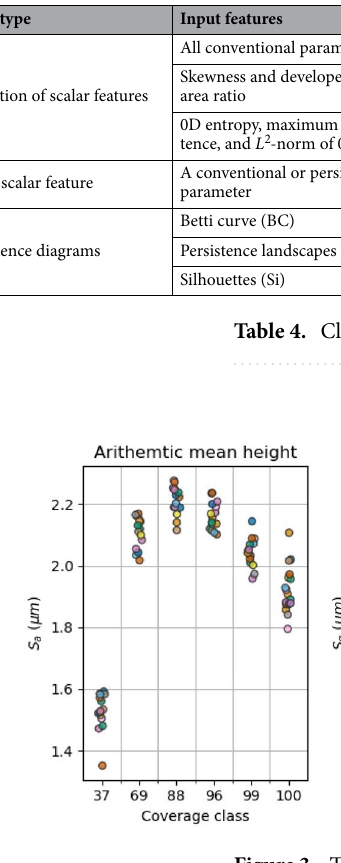
Figure 3. The conventional surface roughness parameters over coverage, colouring by impact sequence. Points marginally shifted in x-direction for better